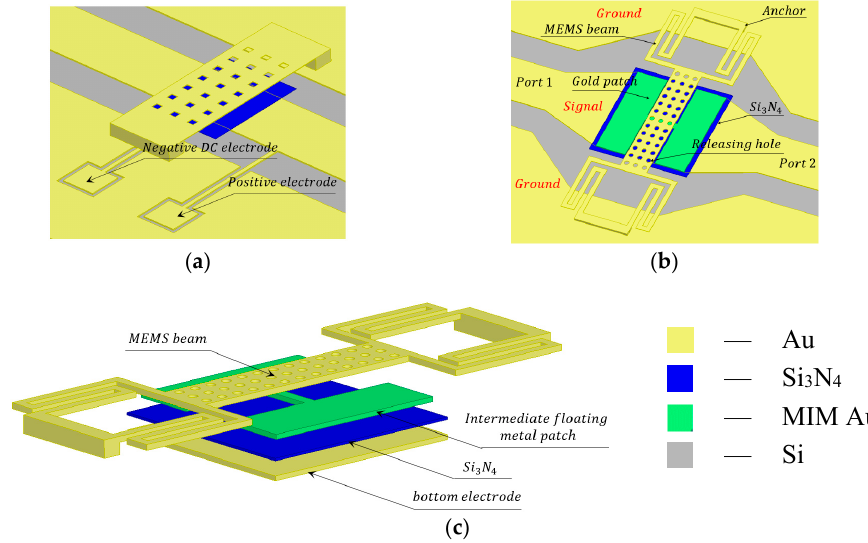
Figure 1. Designed high-capacitance-ratio MEMS switch model. ( a ) Conventional MEMS switch; ( b ) The top view of the proposed MEMS switch; ( c ) The dismantling figure of the MEMS switch. (The gold material is illustrated by yellow and green for the sake of representing different layers.)